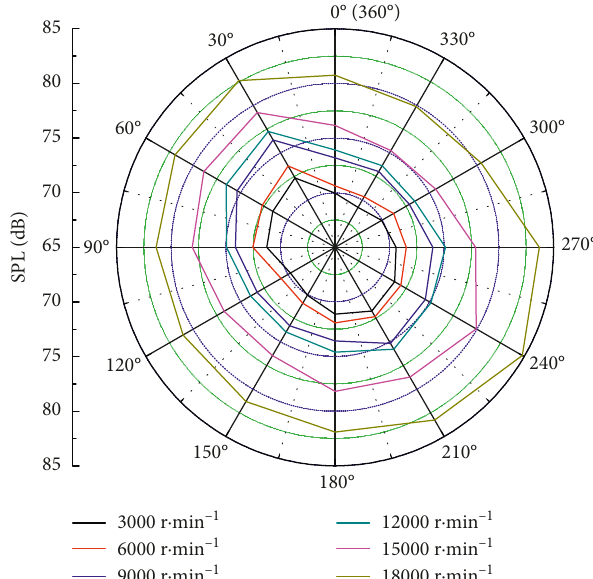
Figure 7: Radiation noise of the ceramic bearing at different speeds.